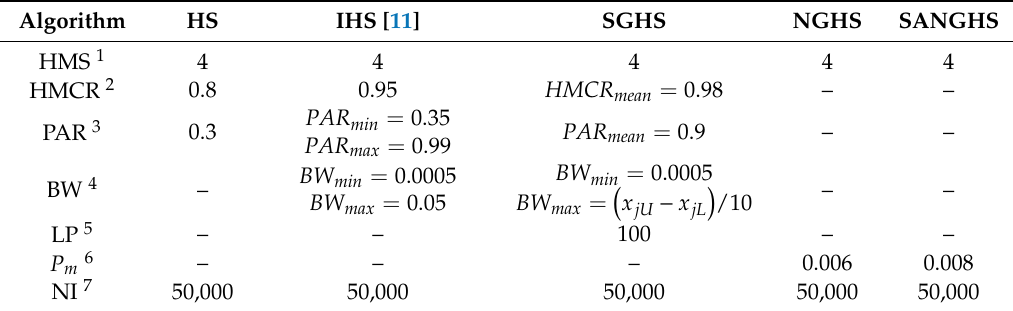
Figure 3. Tension/compression spring design. Figure 3. Tension / compression spring design. Table 6. Parameters of compared harmony search (HS) algorithms in the tension / compression spring Table 6. Parameters of compared harmony search (HS) algorithms in the tension/compression spring design engineering design engineering problem.